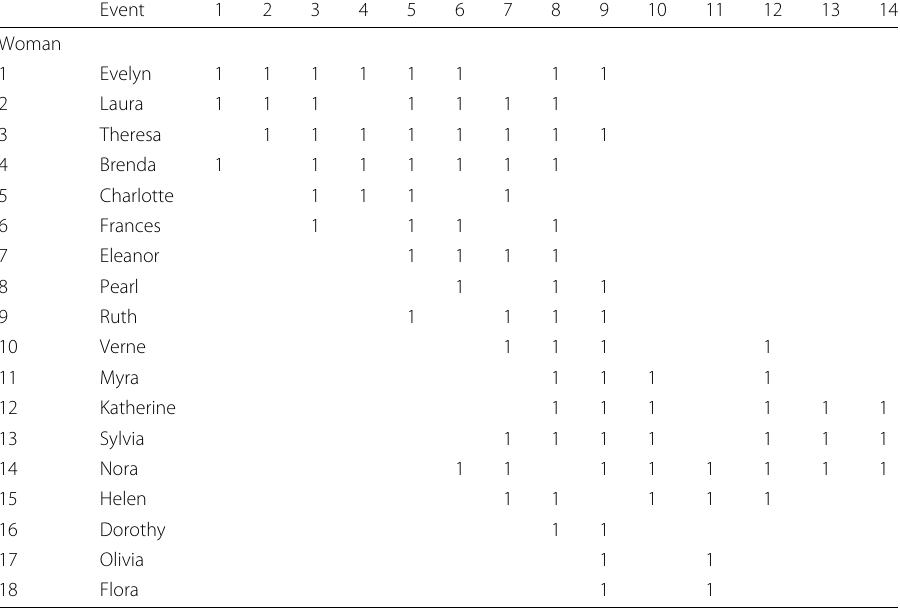
Table 8 Representation of the adjacency matrix of Southern Women bipartite network,